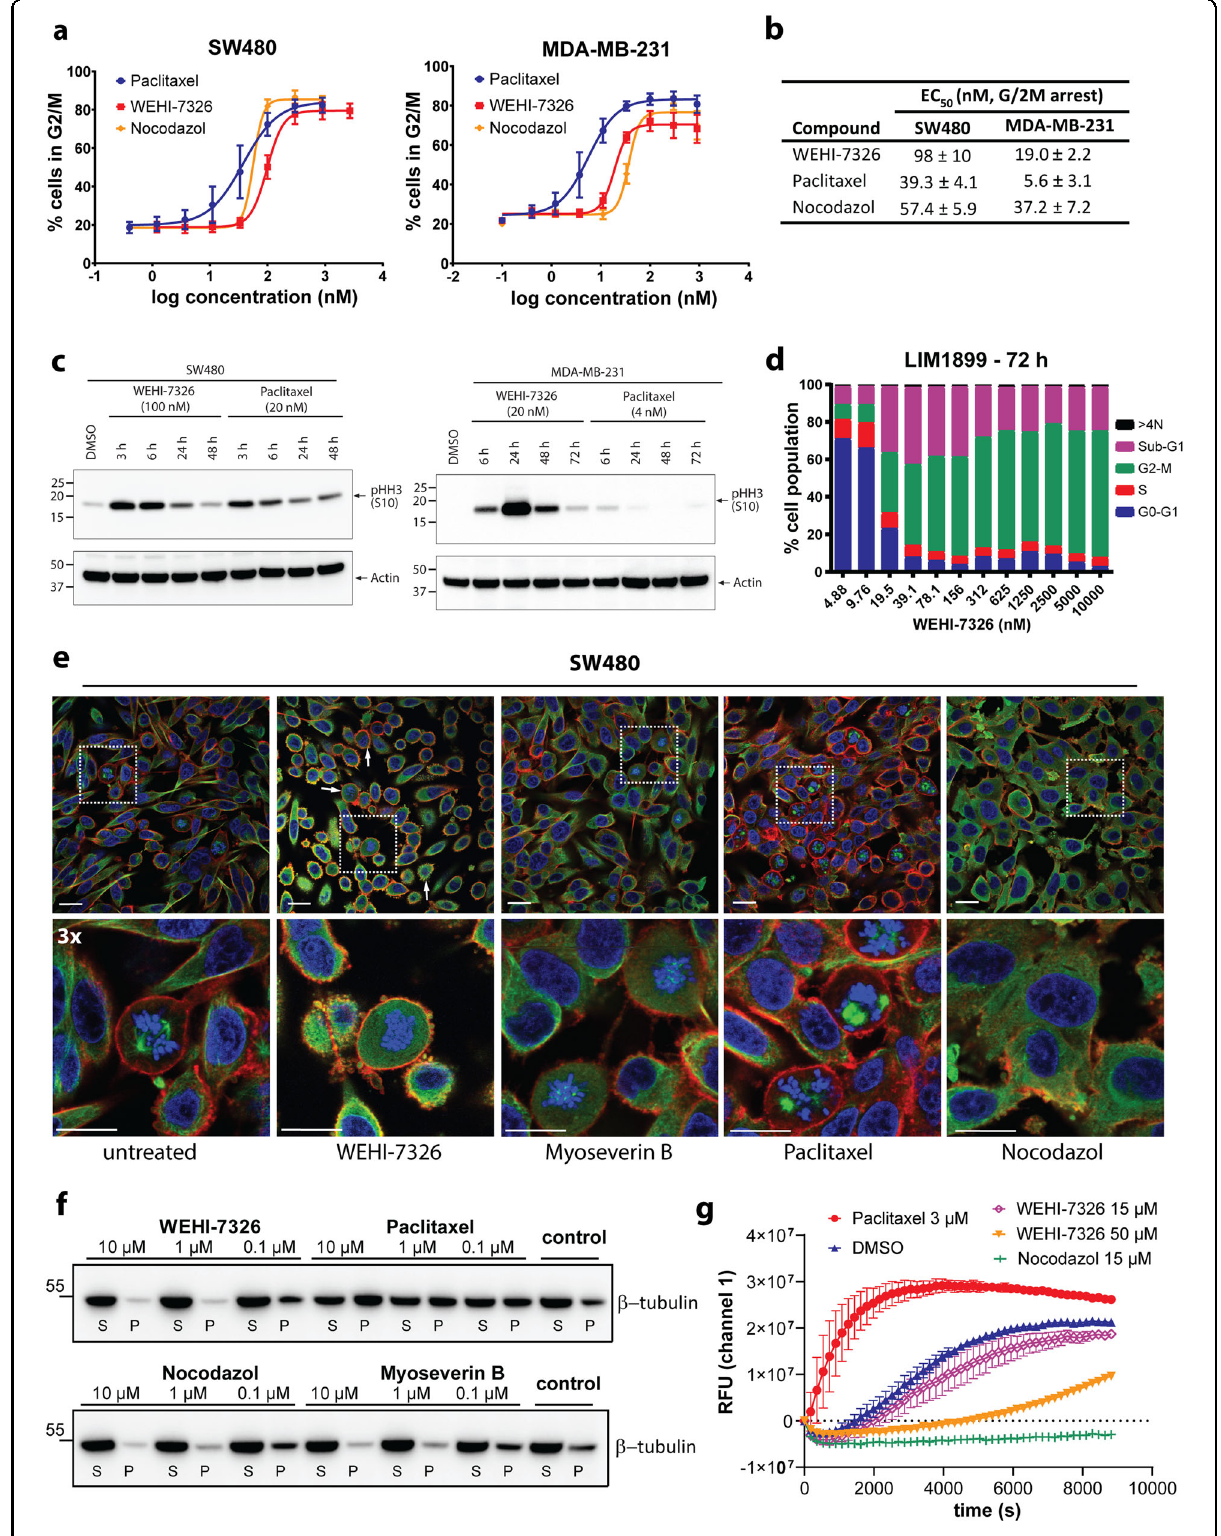
Fig. 2 (See legend on next